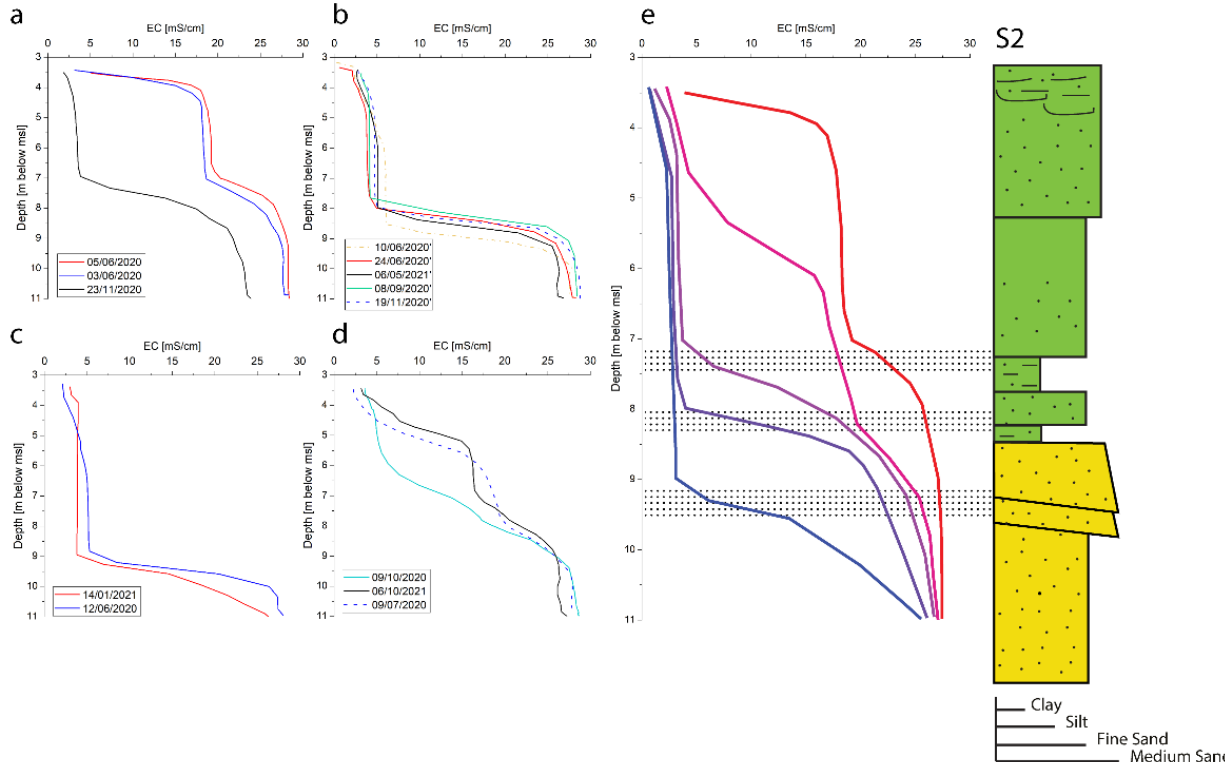
Figure 4 . EC profiles collected in S2 well. Panels ( a – d ) show the 4 configurations assumed by the EC curve during the observed period. The model in panel ( e ) summarizes the configurations and compares them with the stratigraphic section, outlining the sedimentary constraints (dotted areas) existing in the subsoil surrounding the monitoring point.